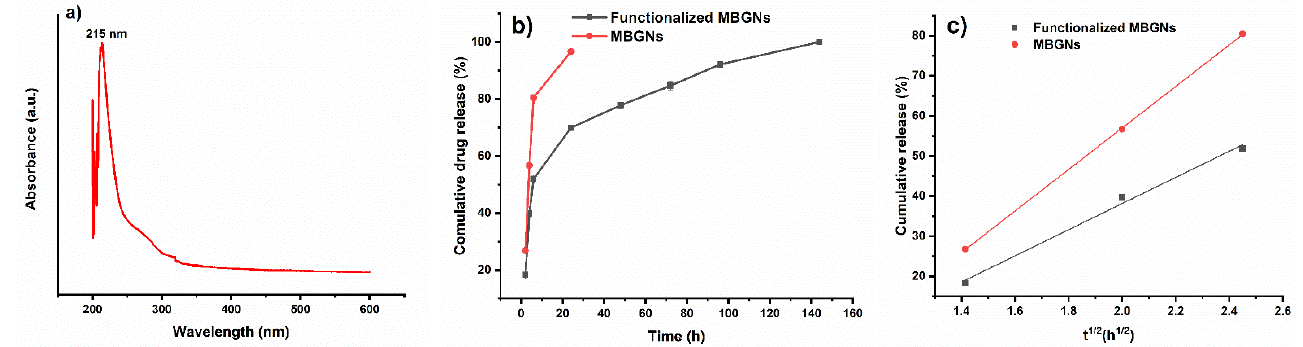
Figure 6. Maximum absorbance ( λ max) of Boswellia sacra extract ( a ), in vitro release study of Boswellia sacra -loaded MBGNs and functionalized MBGNs in PBS ( b ) and data for the first 6 h fitted to the Higuchi model ( c ). Table 4. The Higuchi dissolution constant and regression factor of MBGNs and functionalized MBGNs.